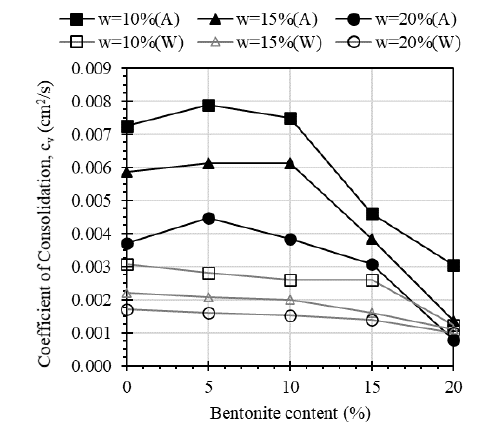
Fig. 8. Coefficient of consolidation as a function bentonite content.